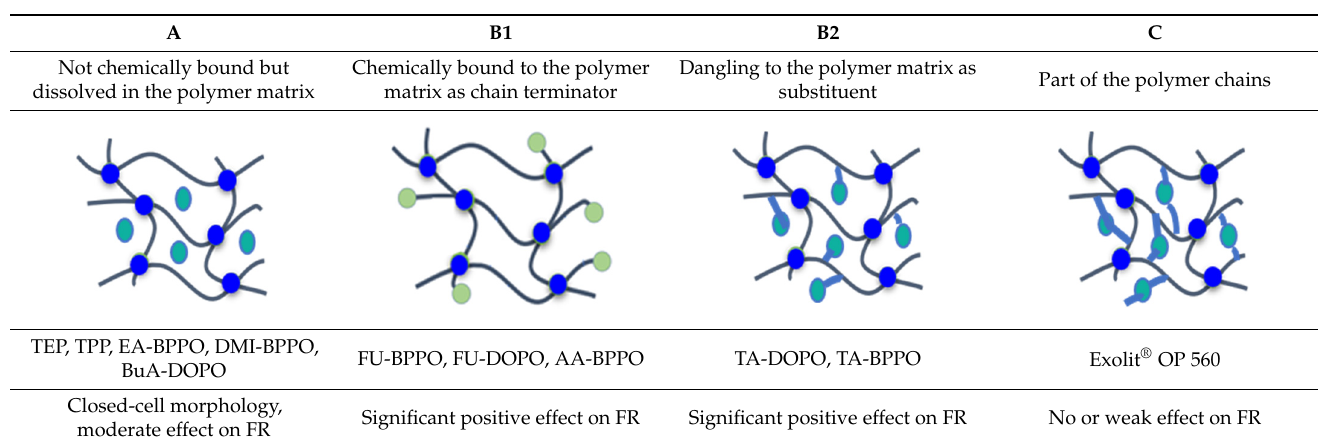
Table 10. Schematic representation of the P-containing FRs incorporated in different manners into rigid PIR foams, typical examples studied, and summarized result.